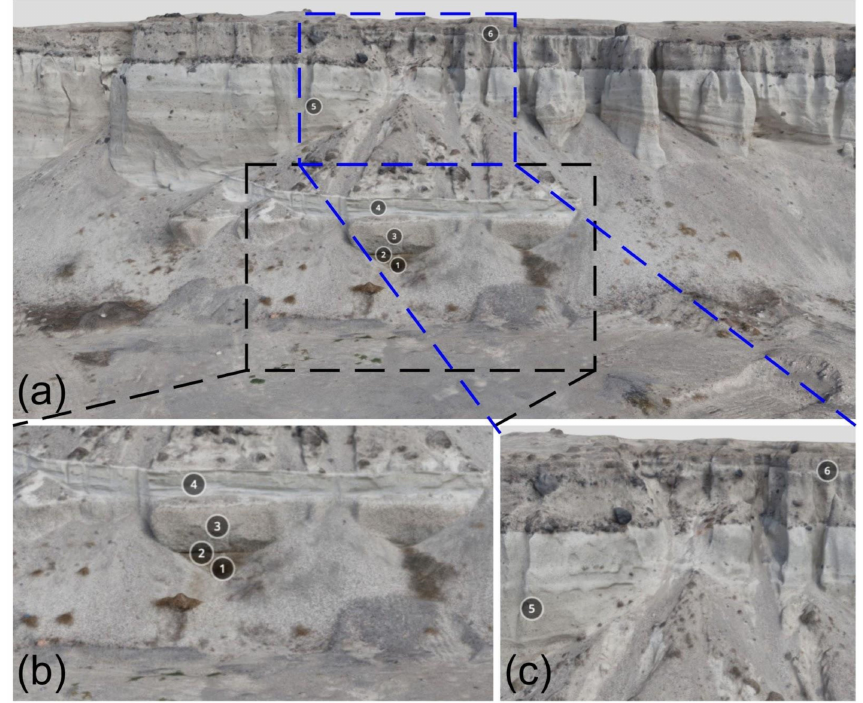
Figure 13. ( a ) A view of Metaxa Mine (view to the south), ( b ) a closer look at the pre-Minoan ( pinmark 1 ) and post-Minoan ( 2–4 ) units, ( c ) a closer look at the Minoan surge deposits and the nonwelded ignimbrite.